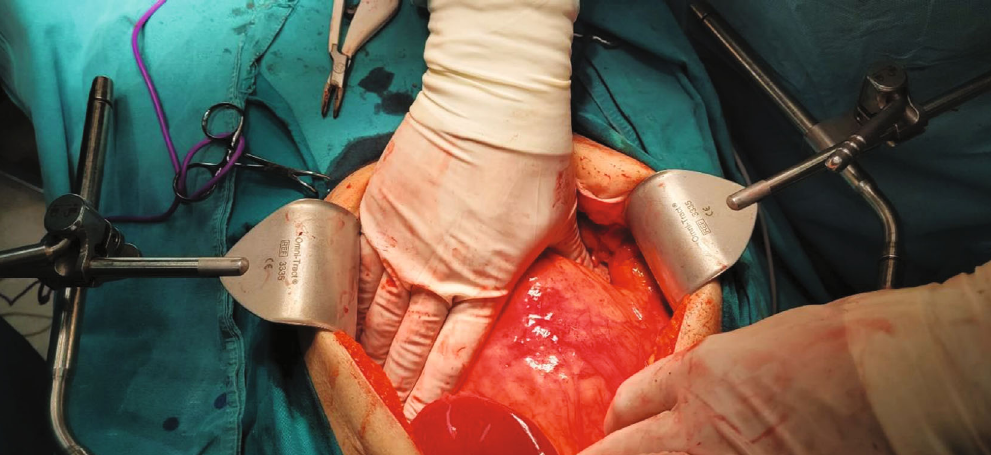
Figure 2: Intraoperative fi nding of a large choledochal cyst.